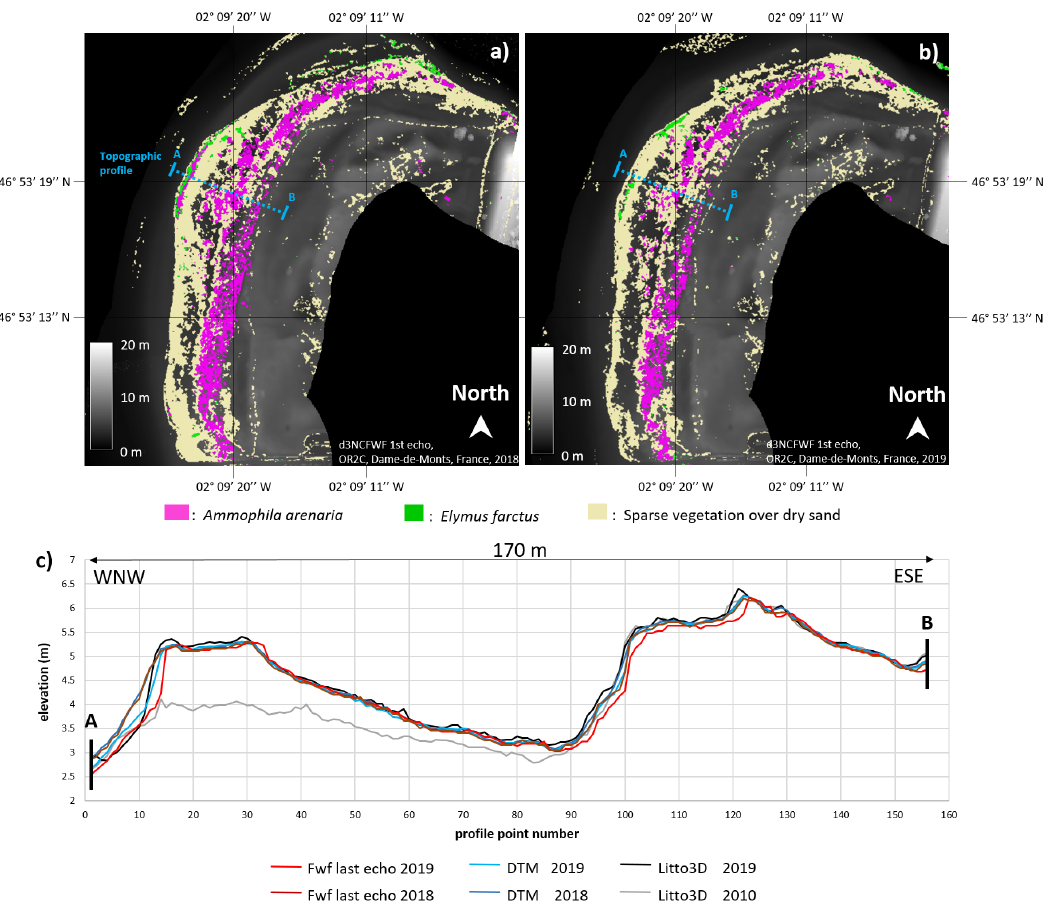
Figure 16. Barre-de-Monts validation area with the same caption as Figure 13. See location c in Figure